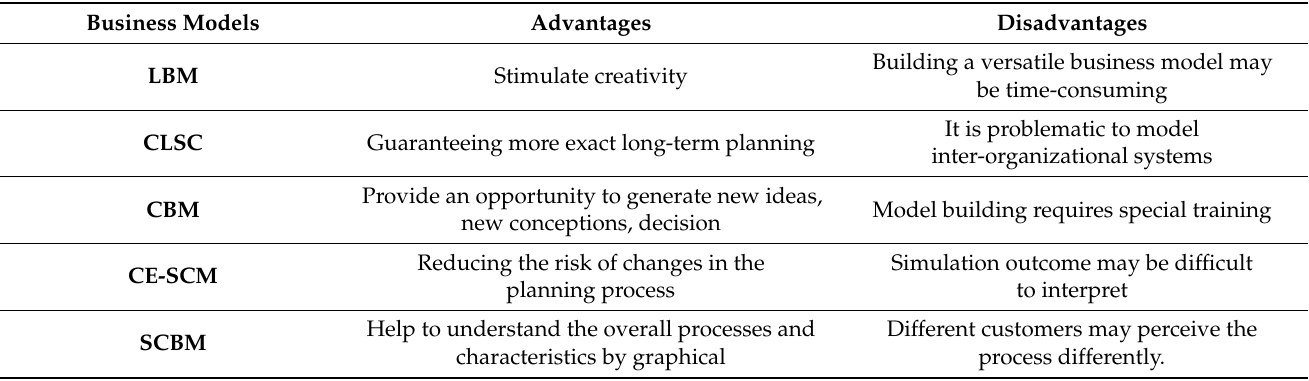
Figure 10. Overall performance ratio of various business models for several question sets. As shown in Table 2, the advantages and disadvantages of these models are compared below: Table 2. Advantages and Disadvantages of Business Models.